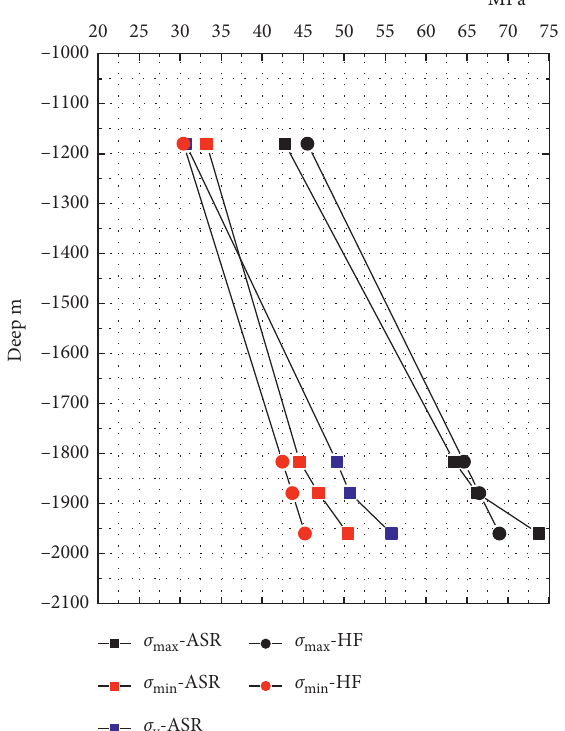
Figure 10: Comparison of test results of ASR and hydraulic fracturing.